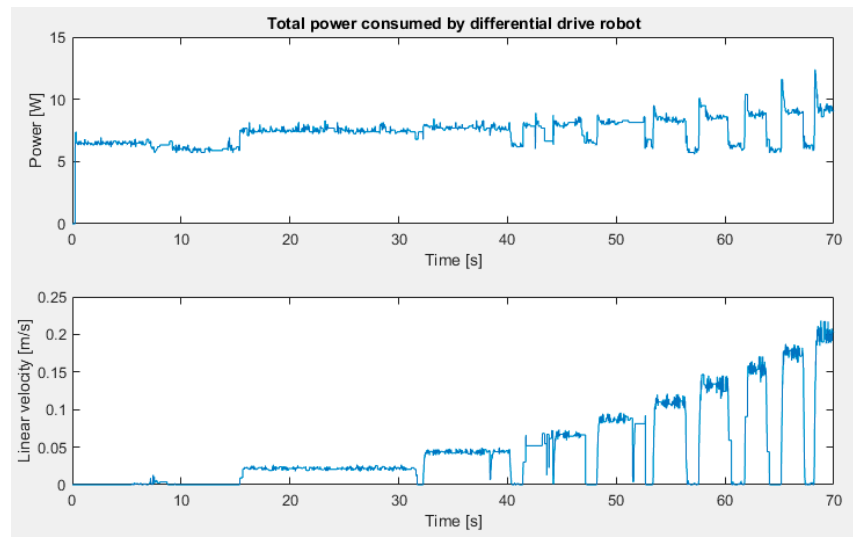
Figure 6. The data collected in the calibration process on the Floor panels.